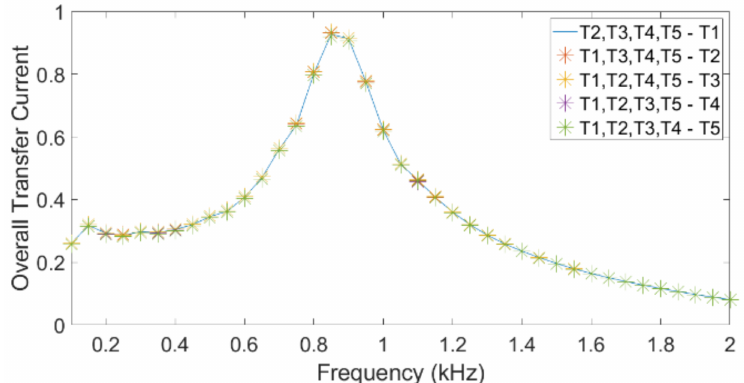
Figure 7. Overall current transfer between turbines: 5-turbine plant.